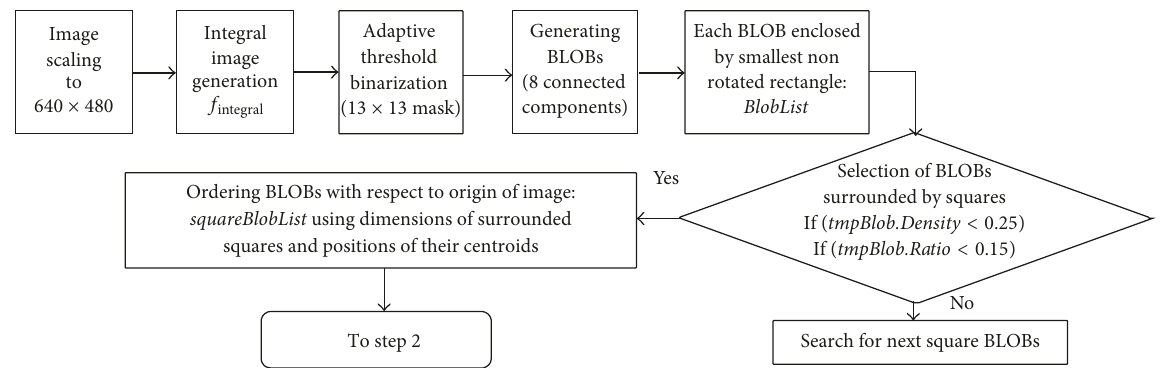
Figure 2: Step 1 : block diagram of algorithm for image preprocessing, binarization, and selection of square BLOBs.